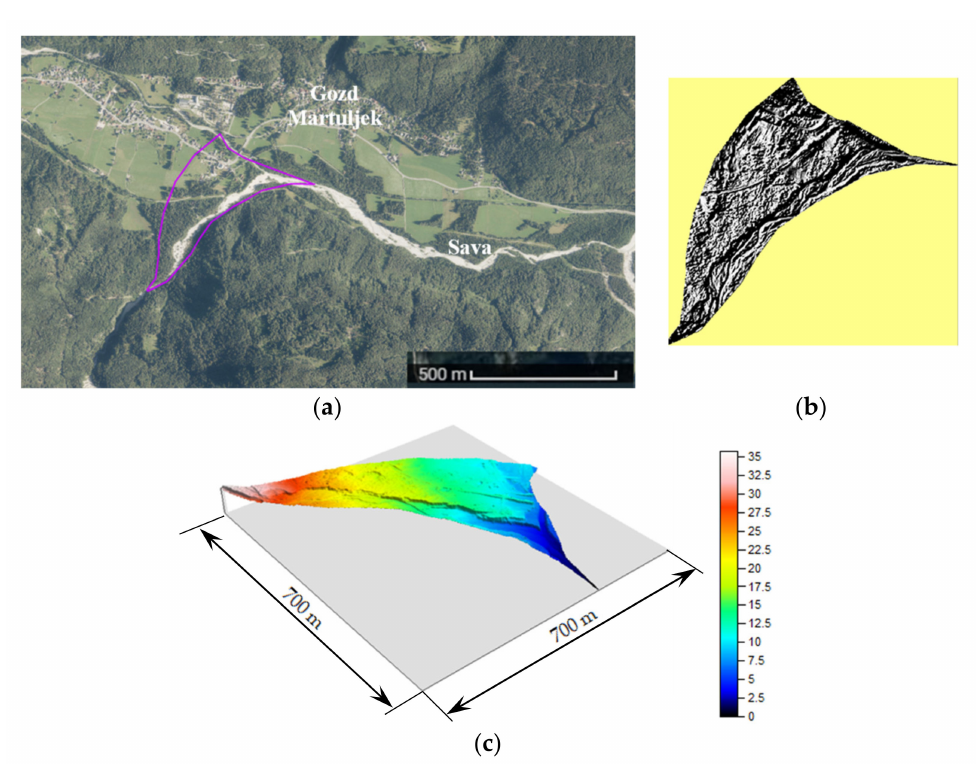
Figure 4. Alluvial fan area No. 7: ( a ) contour of the area in the cartography map (Maxar Technologies data cartograph, 2021); ( b ) ASTER GDEM; ( c ) DEM 3D perspective